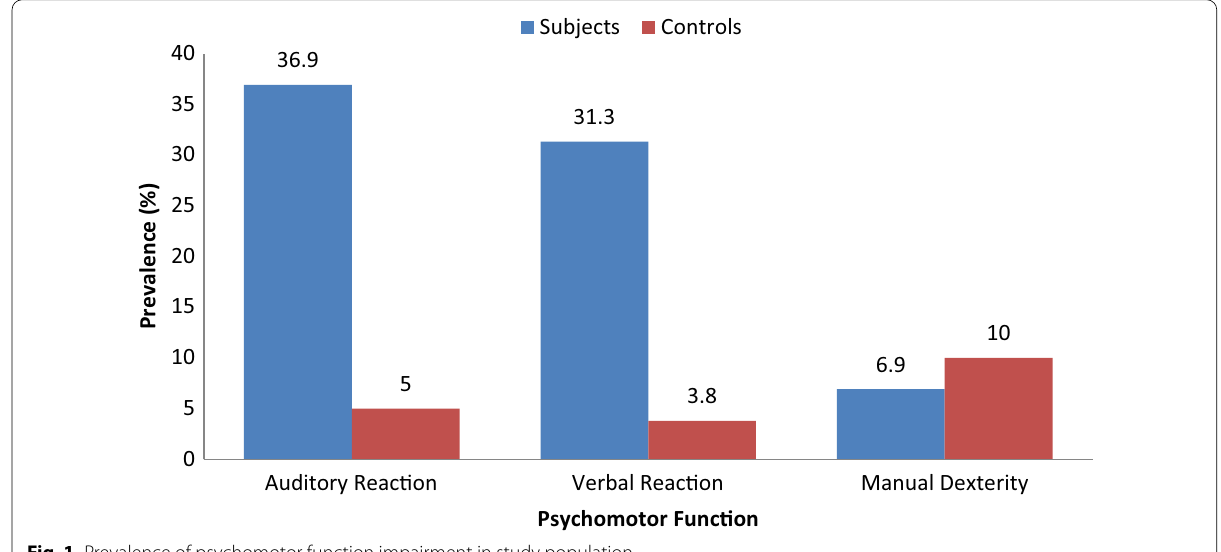
Fig. 1 Prevalence of psychomotor function impairment in study population